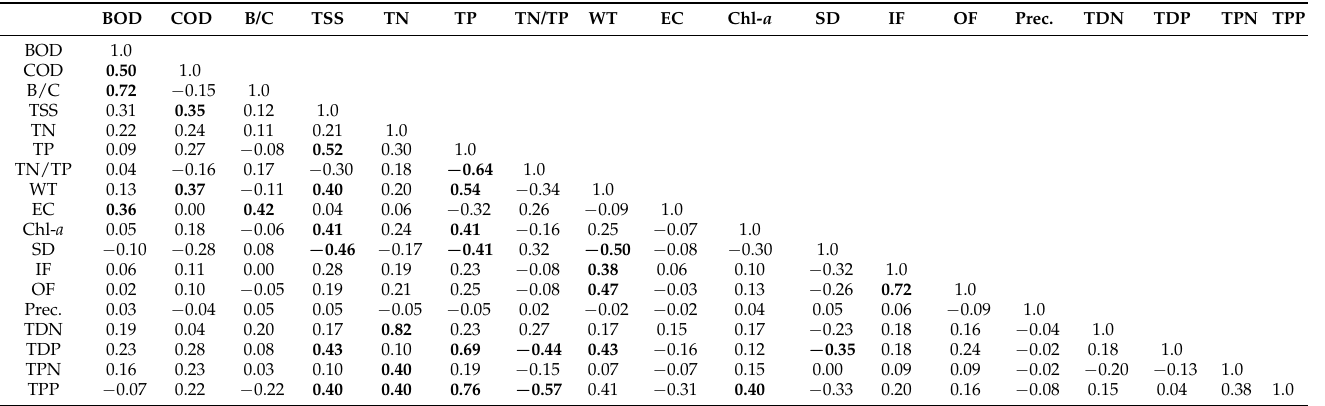
Table 2. Pearson correlation analysis of water quality and hydrological parameters during